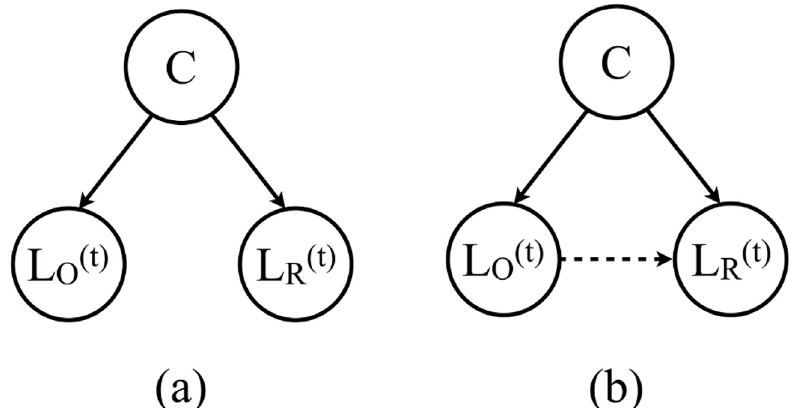
Fig 3. A Bayesian network model for length coordination. The network containing contextual factors, C , the length of an utterance, L ð t Þ O , and the length of the response, L ð t Þ R . (a) The lengths are correlated only due to contextual factors. (b) The lengths are correlated due to both contextual factors and potential effect of turn-by- turn level coordination (represented with the dotted